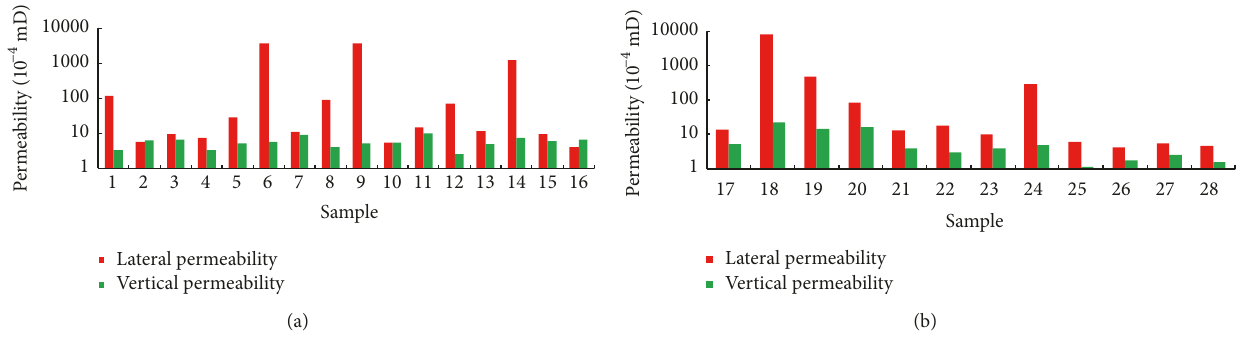
Figure 3: Lateral and vertical permeability histograms. (a) Samples of the Lower Cambrian shale, from Well JiangYe 1 and JiangYe 2. (b) Samples of the Lower Silurian shale, from Well PengYe 1. See Figure 1 for the well